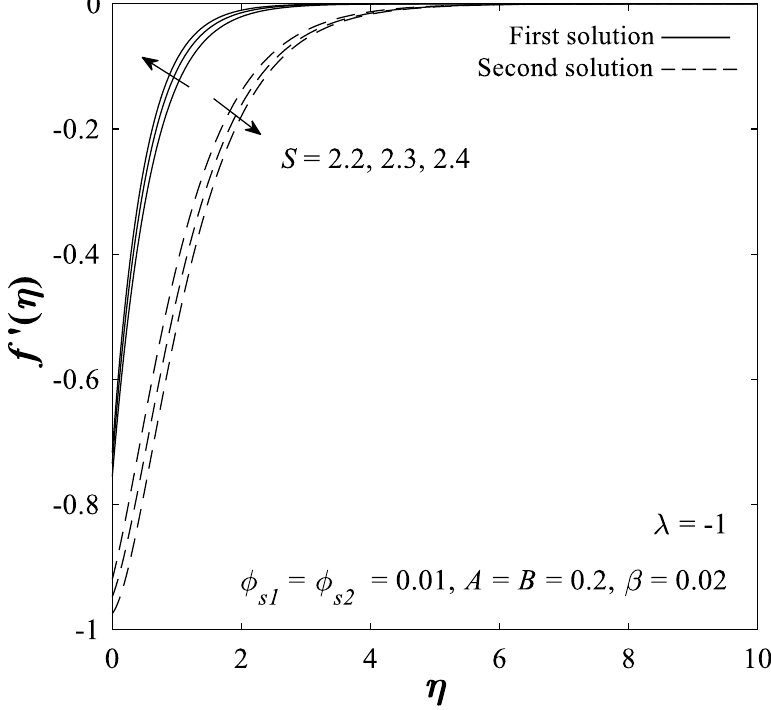
Figure 12. Velocity profile f (cid:48) ( η ) for varied S .